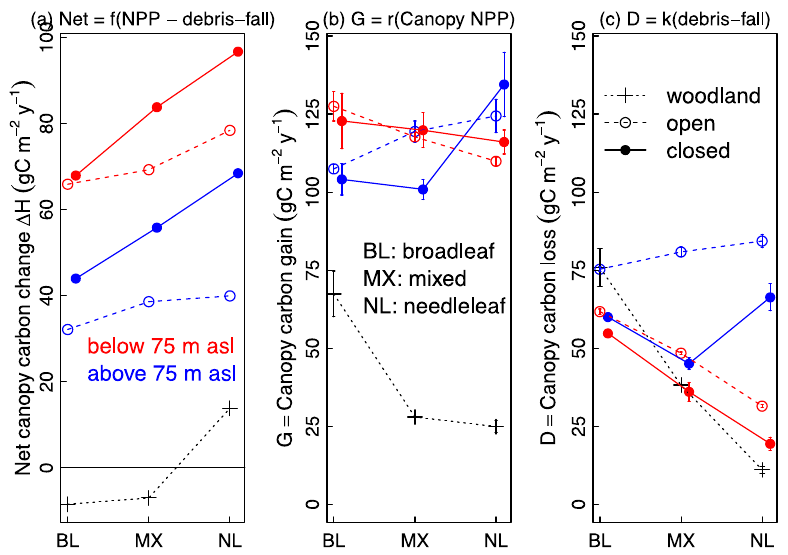
Figure 5. Interaction plots of canopy C flux by forest type, structure, and elevation. ( a ) Net canopy C change ∆ H . ( b ) Canopy carbon gain and ( c ) canopy carbon loss. Color gives elevation, point and line type give structure. Error bars on carbon gain and loss calculated from deconvolution standard errors and delta method.